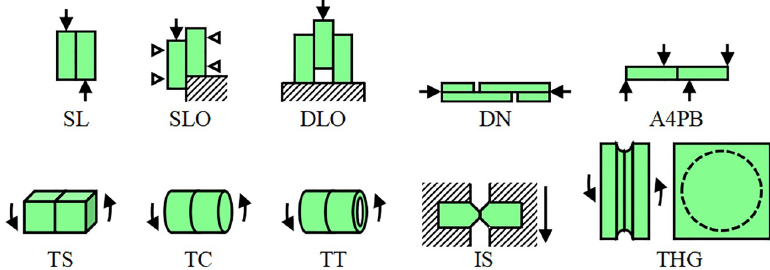
Fig. 1 Methods of shear (and apparent shear) strength evaluation available for ceramic joints. Reproduced with permission from Ref. [12], © Elsevier B.V. 2013; Ref. [13], © The American Ceramic Society 2012; Ref. [14], © The American Ceramic Society